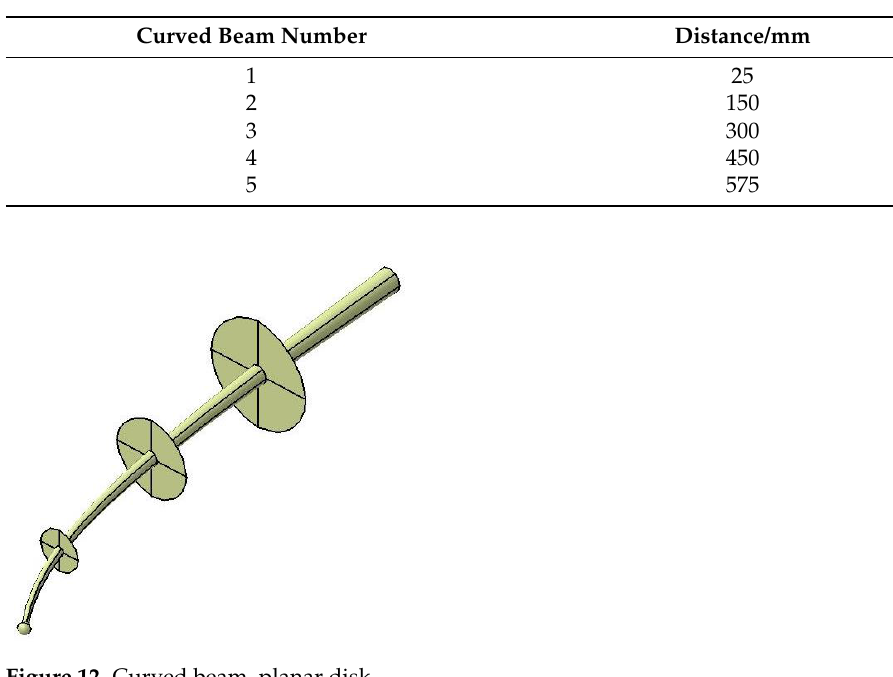
Figure 13. Top view of internal wing structure arrangement.